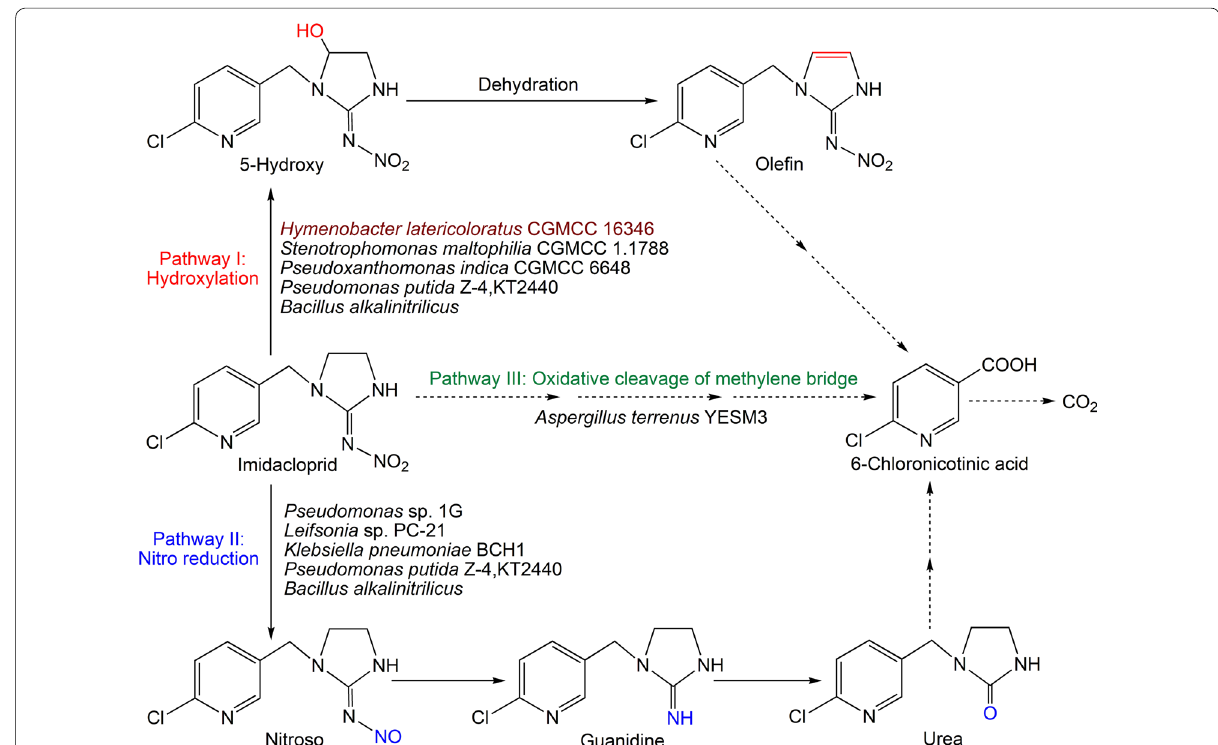
Fig. 1 Metabolic pathway of imidacloprid in